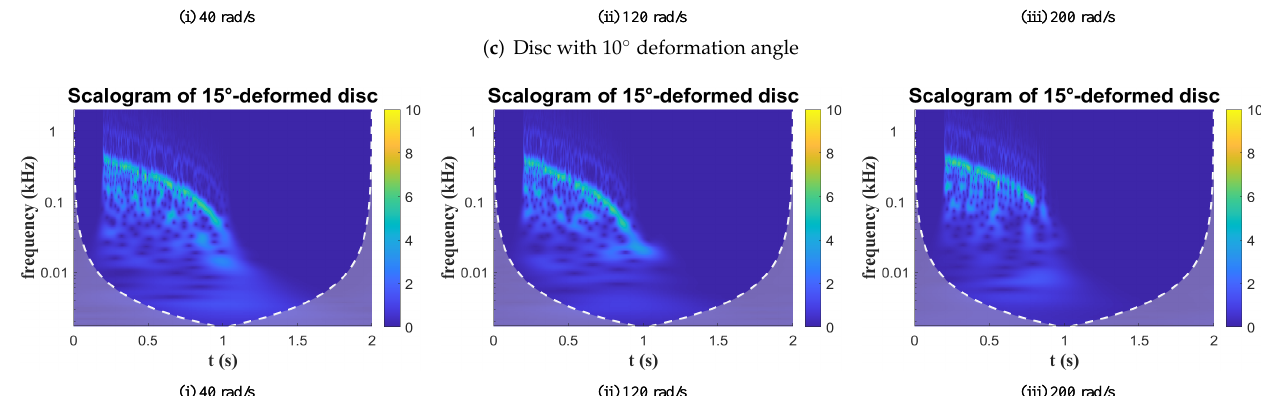
Figure 13. Scalogram: BC = 7 mm, initial force = 7